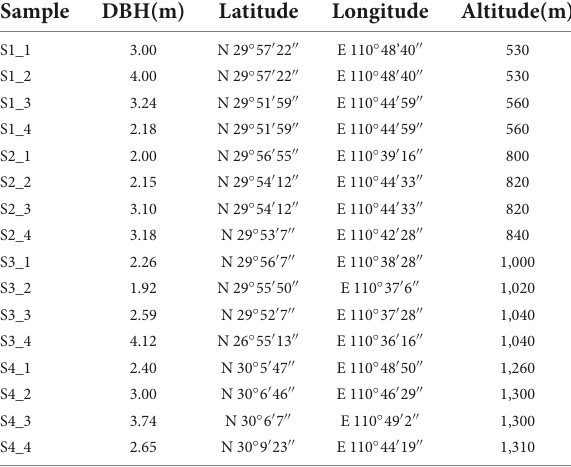
TABLE 1 Altitude and other information of sampling